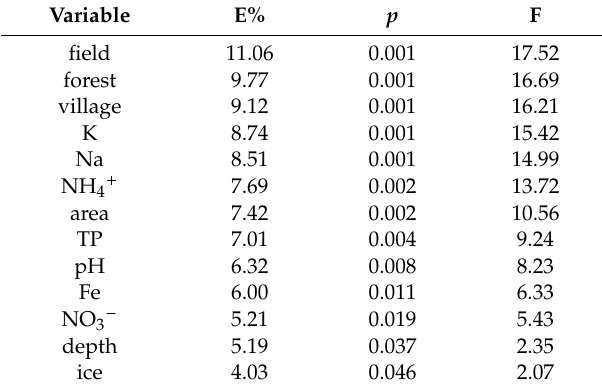
Table 10. Statistical parameters for the CCA analysis (E%—the explanation percent, p —statistical significance, F—the result of the analysis of variance).